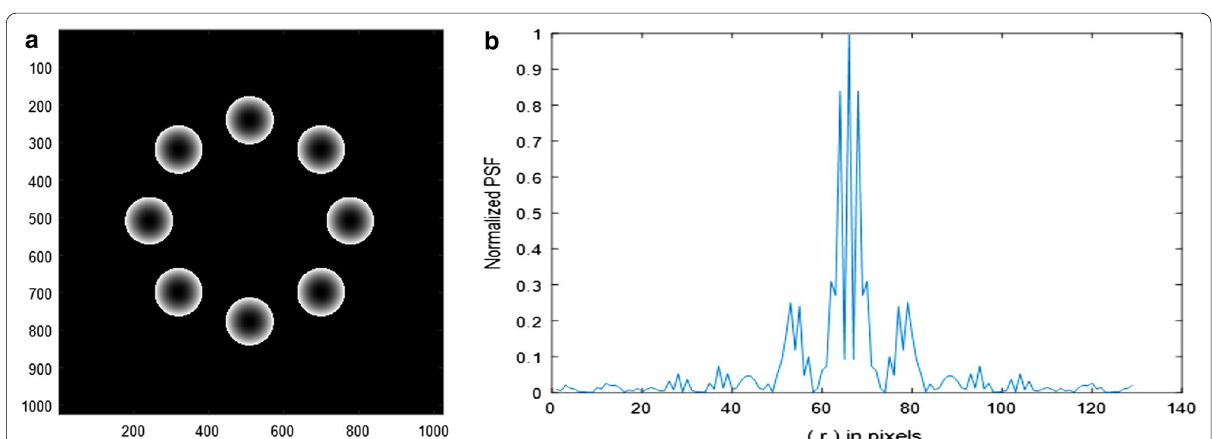
Fig. 2 a Eight equally spaced linear apertures where the centers placed at fixed distance radius of each conic aperture 64 pixels. b Normalized PSF as a function of radial distance r (pixels) in the Fourier plane for a lens limited by the = aperture shown in Figure